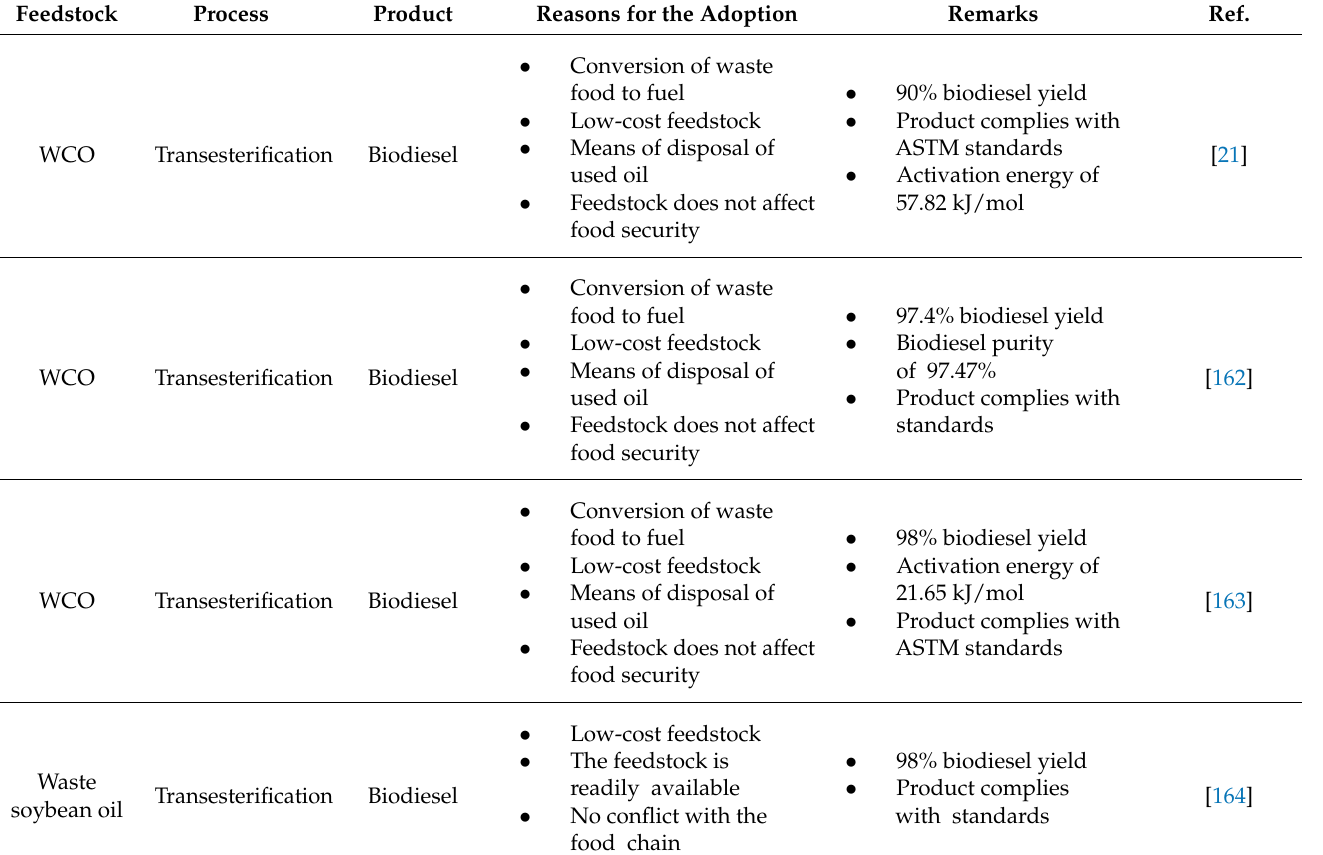
Table 9. Recent examples of conversion of waste to